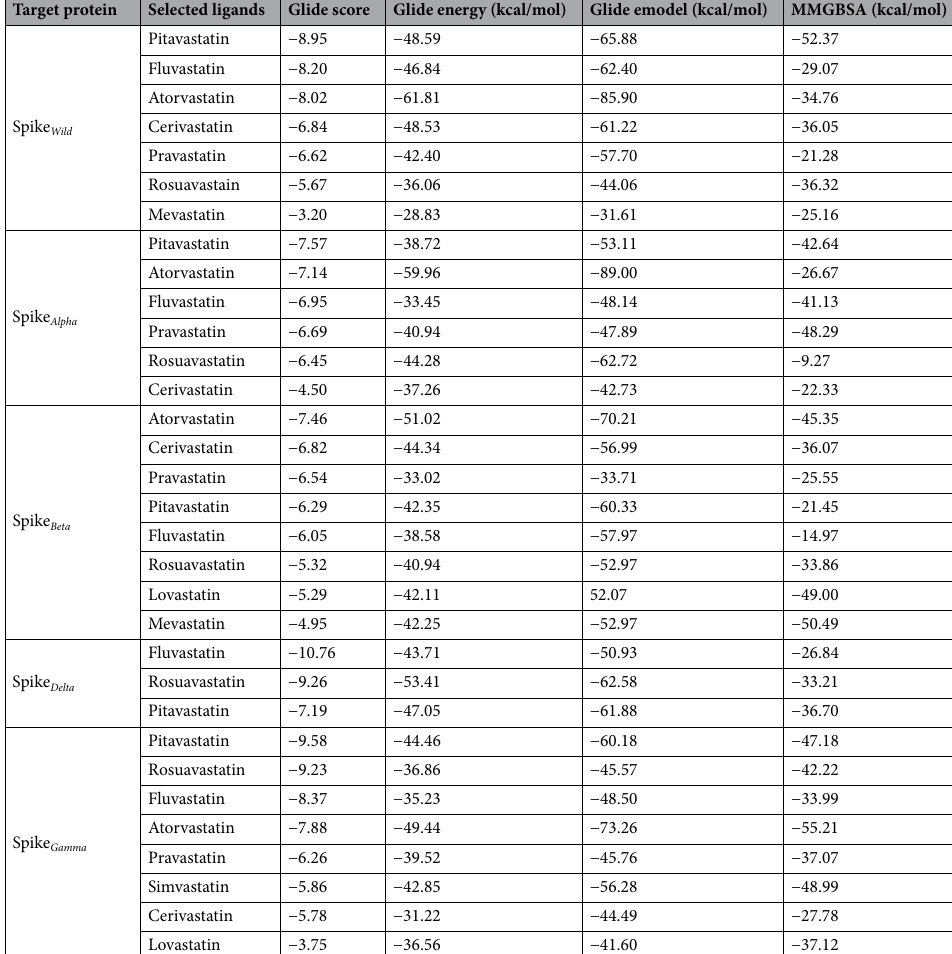
Table 5. Docking analysis of the statins against wild-type and mutant Spike